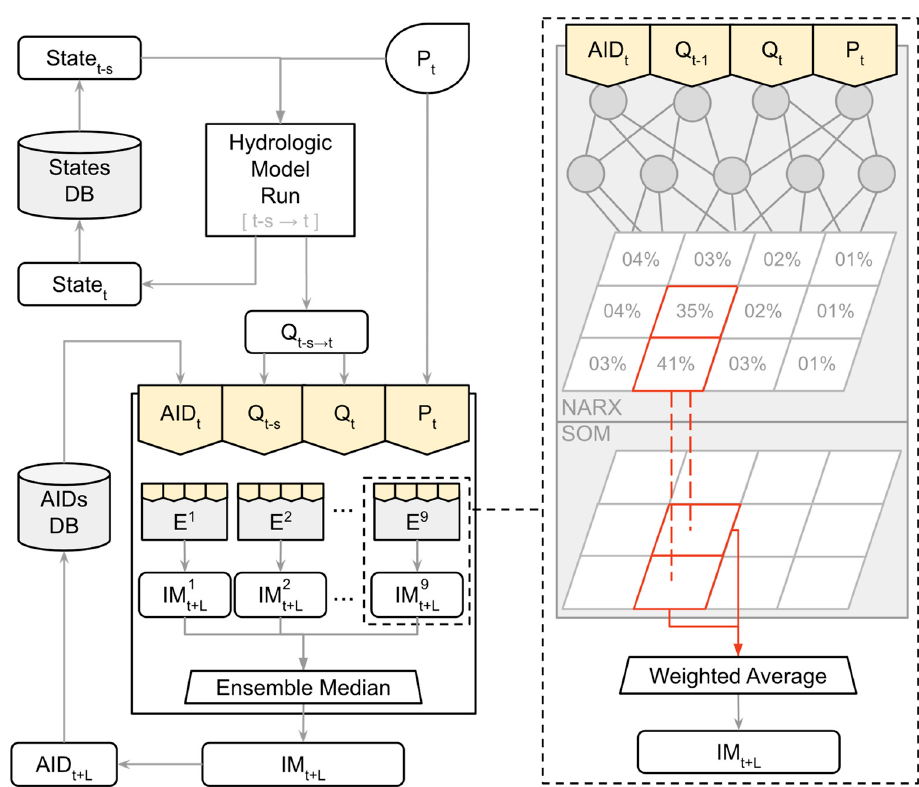
Figure 4. Overview of the system in the runtime setup demonstrating how the inundation map (IM) forecasted for a lead time L is obtained from the current data available at time t and from previous steps s. It represents an ensemble system composed by 9 predictors (E1, …, E9), NARX components have 4 input and 5 hidden nodes (interconnected circles), and SOMs have 3 × 4 topological nodes (square grids).